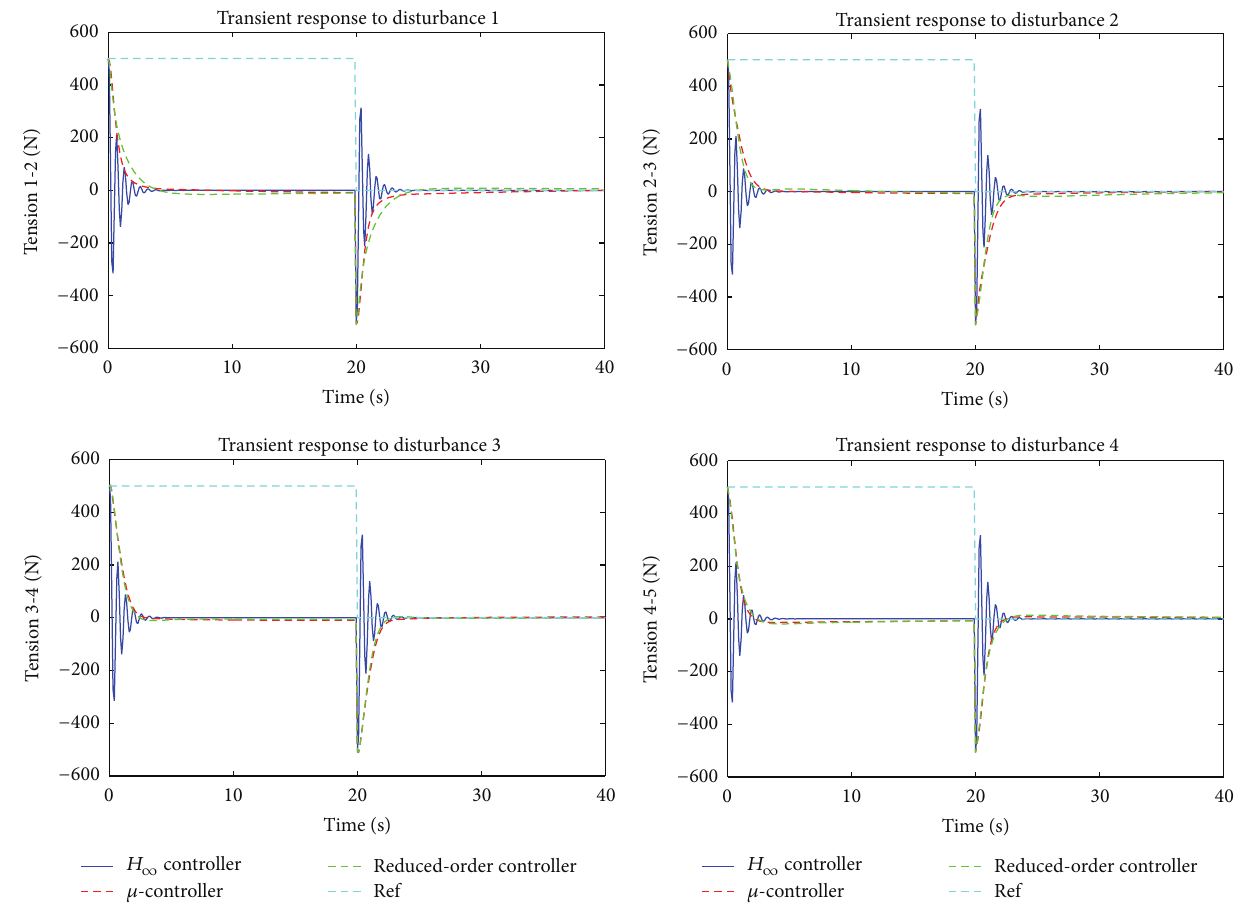
Figure 17: Comparison of transient response to disturbance